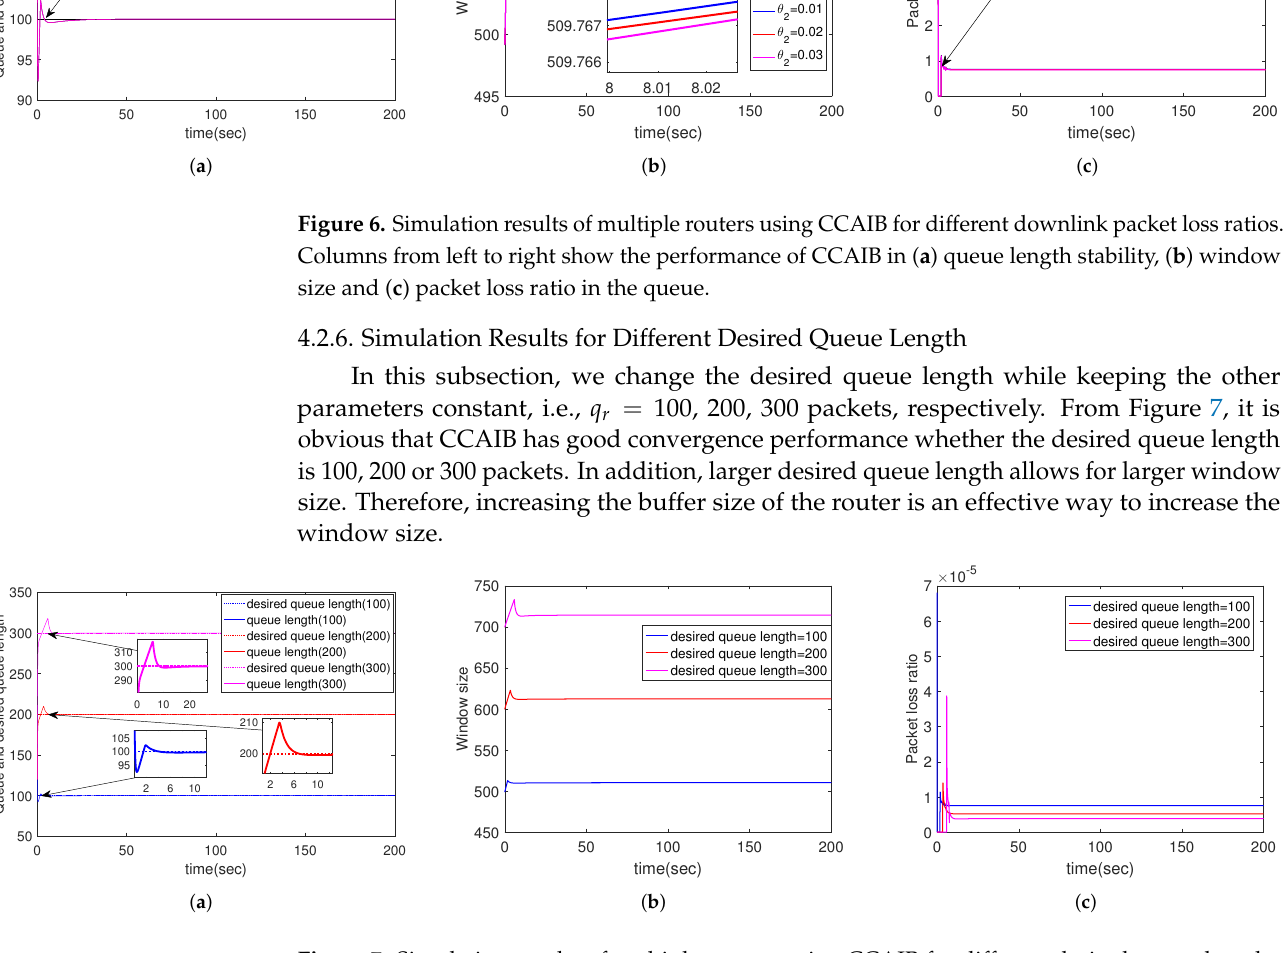
Figure 7. Simulation results of multiple routers using CCAIB for different desired queue lengths. Columns from left to right show the performance of CCAIB in ( a ) queue length stability, ( b ) window size and ( c ) packet loss ratio in the